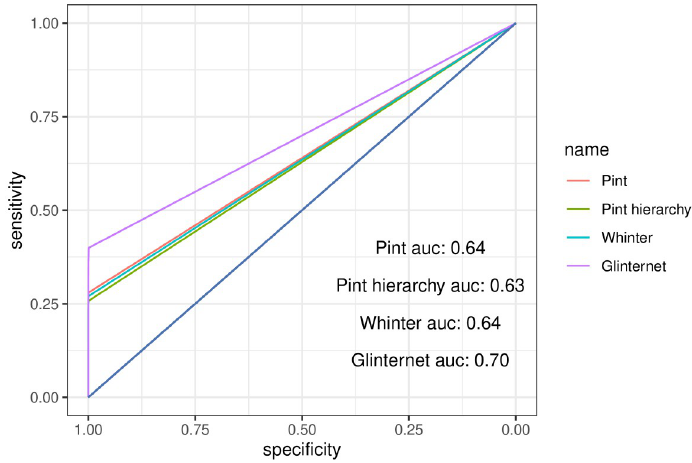
Fig 4. Overall receiver operating characteristic curves for all p = 4, 000 data sets.